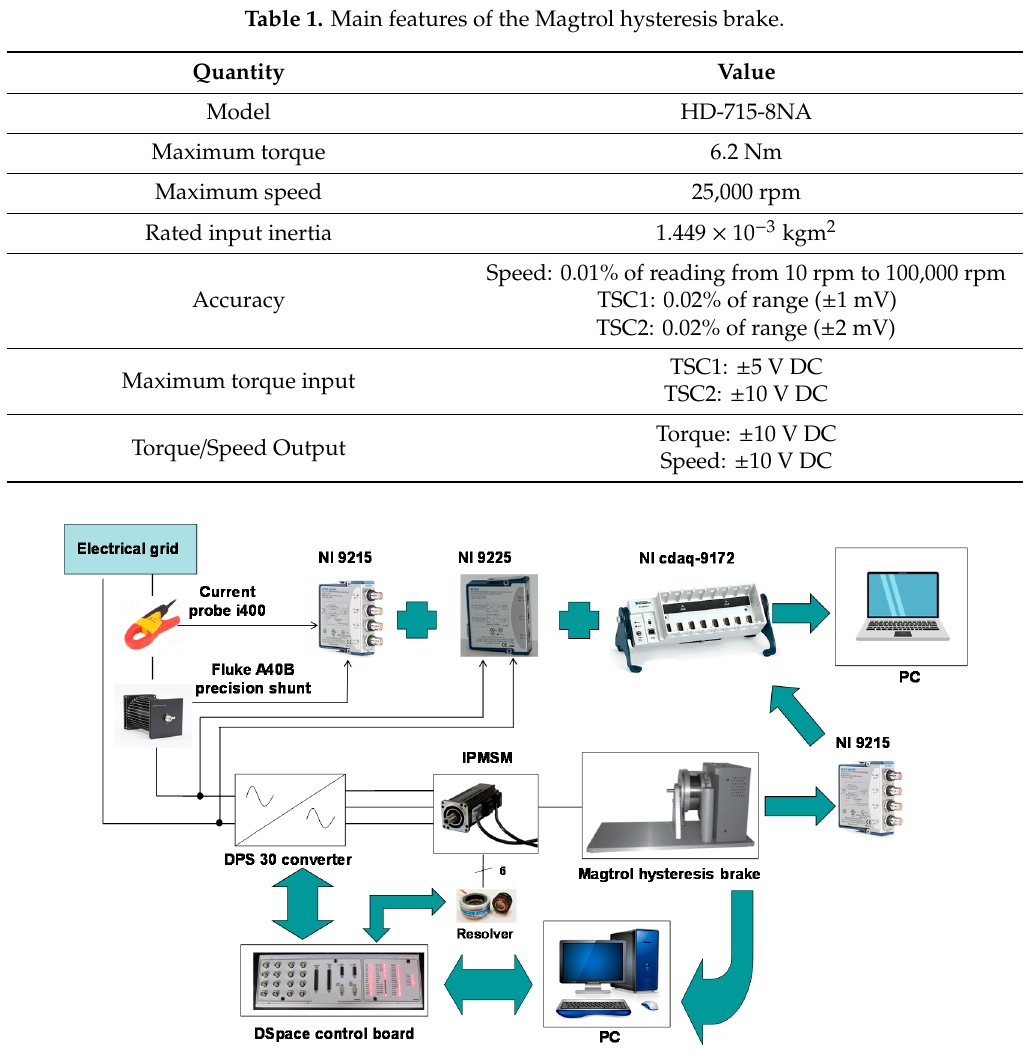
Figure 3. Schematic representation of the test bench. Table 1. Rated values and parameters of IPMSM under test.